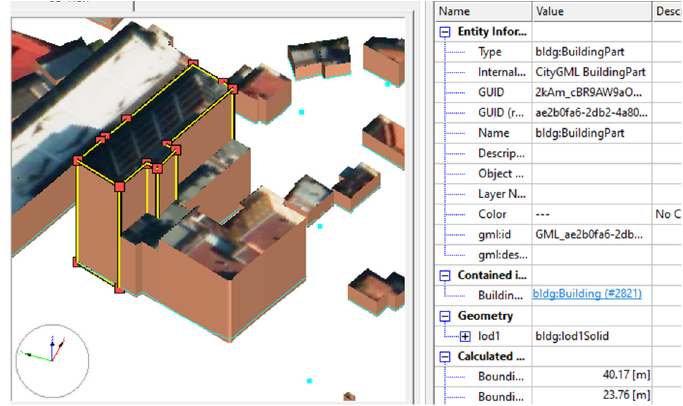
Figure 9. Building modeled with building parts in FZKViewer.